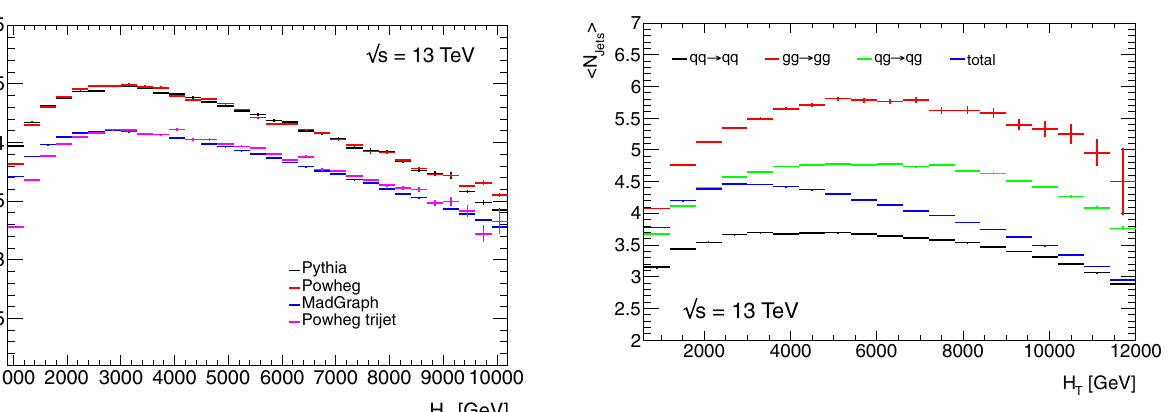
Fig. 3 The average number of jets per event ( (cid:3) N Jet (cid:4) ) as a function of H T for the 3 leading subprocesses. Events were generated using Pythia. Note that the presence of gluons in the final state entails higher (cid:3) N Jet (cid:4) . Note also that the (cid:3) N Jet (cid:4) drop at high values of H T appears for all three